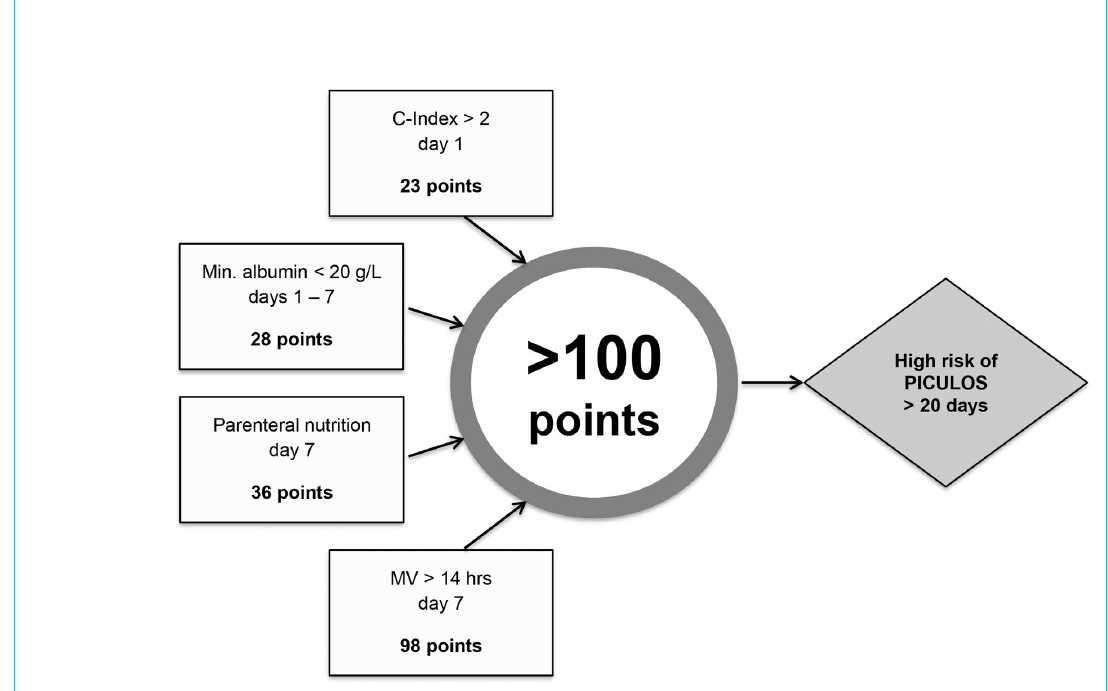
Figure 4: Multivariable model to predict a prolonged length of stay in the surgical ICU in Basel. C-Index = Charlson Comorbidity Index; MV = mechanical ventilation, PICULOS = prolonged intensive care unit length of